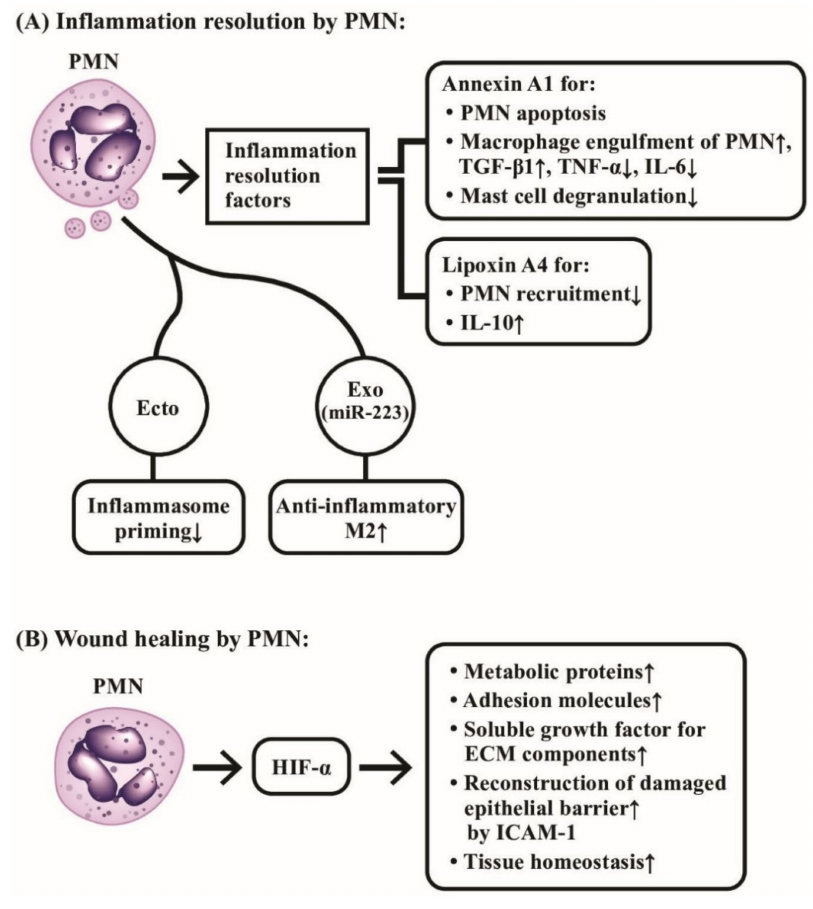
Figure 10. The molecular mechanism of neutrophils in inflammation resolution and wound healing. ( A ) Neutrophils release annexin A1 and lipoxin A4 as inflammation-resolution factors to suppress the inflammatory functions of PMNs, macrophages and mast cells. In addition, PMN-released ectosomes (Ecto), and exosomes (Exo) containing miR-223 also play important roles in suppressing inflammation. ( B ) Neutrophil-released hypoxia-induced factor- α (HIF- α ) mediates a crucial role in tissue homeostasis and wound healing through induction of many tissue repair molecules after inflammation resolution. ECM: extracellular matrix; ICAM: intercellular adhesion molecule; miR: microRNA; M2: type 2